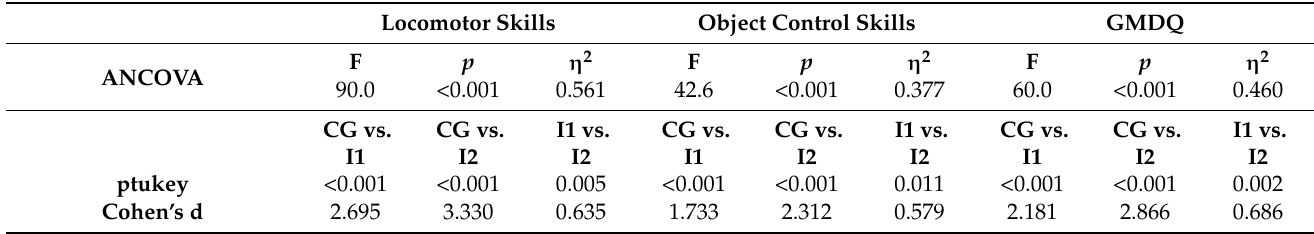
Table 2. Measures of effect size in ANCOVA analysis and Tukey–Kramer post hoc